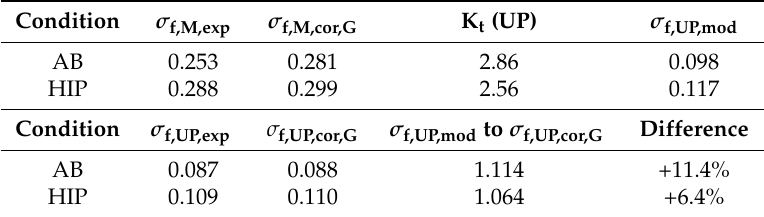
Table 9. Assessment of the surface roughness on the fatigue strength after Gerber.